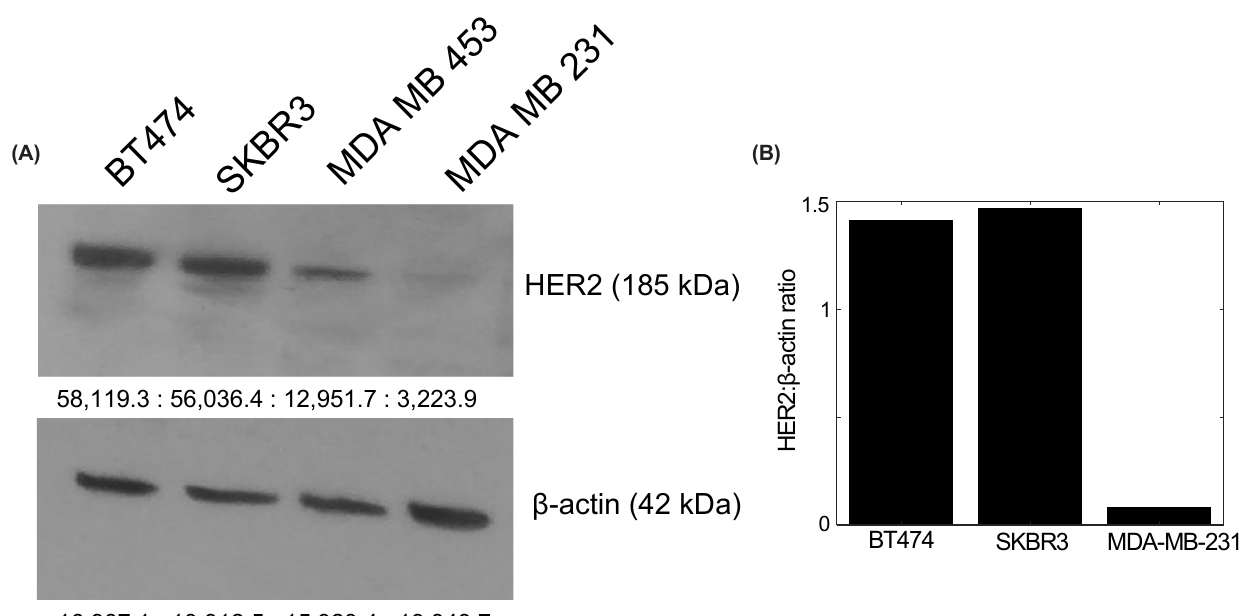
Figure 2. HER2 quantification in BT474, SKBR3, and MDA-MB-231 cells. ( A ) Expression of HER2 protein (185 kDa) in each cell line. β -actin (42 kDa) was used as an internal control. Visible protein bands are seen in the BT474 and SKBR3 HER2+ cell lines, while MDA-MB-231 shows little to no expression. ( B ) HER2: β -actin ratio in each cell line. BT474 and SKBR3 cells have ratios of 1.41 and 1.46, respectively. MDA-MB-231 has a ratio of 0.08, confirming no HER2 amplification. The uncropped blots are shown in Supplementary Figure S2.